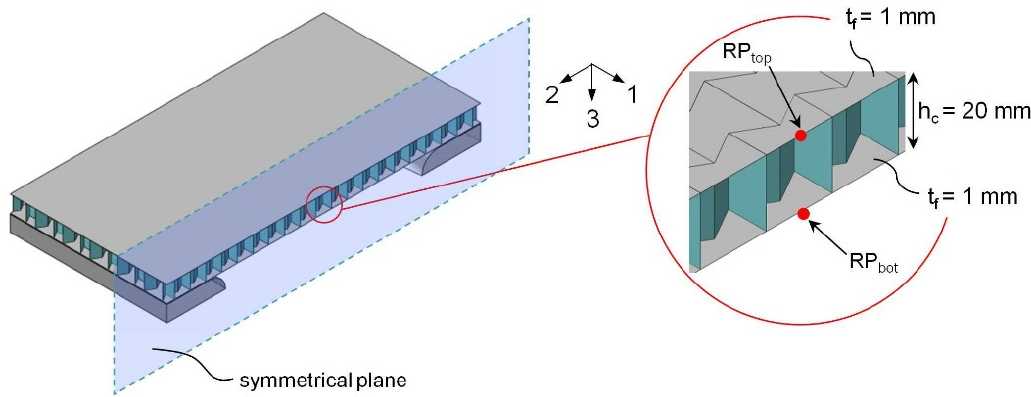
Figure 15. Position of the discrete evaluation points in the center of the panel on the upper and lower cover surfaces.